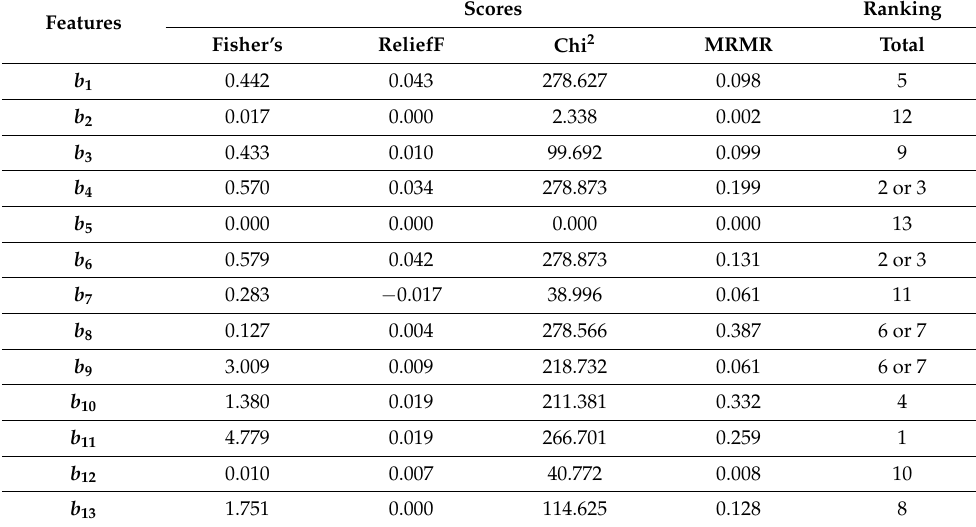
Table 4. Results of applying filters for the features of the bellows signals.